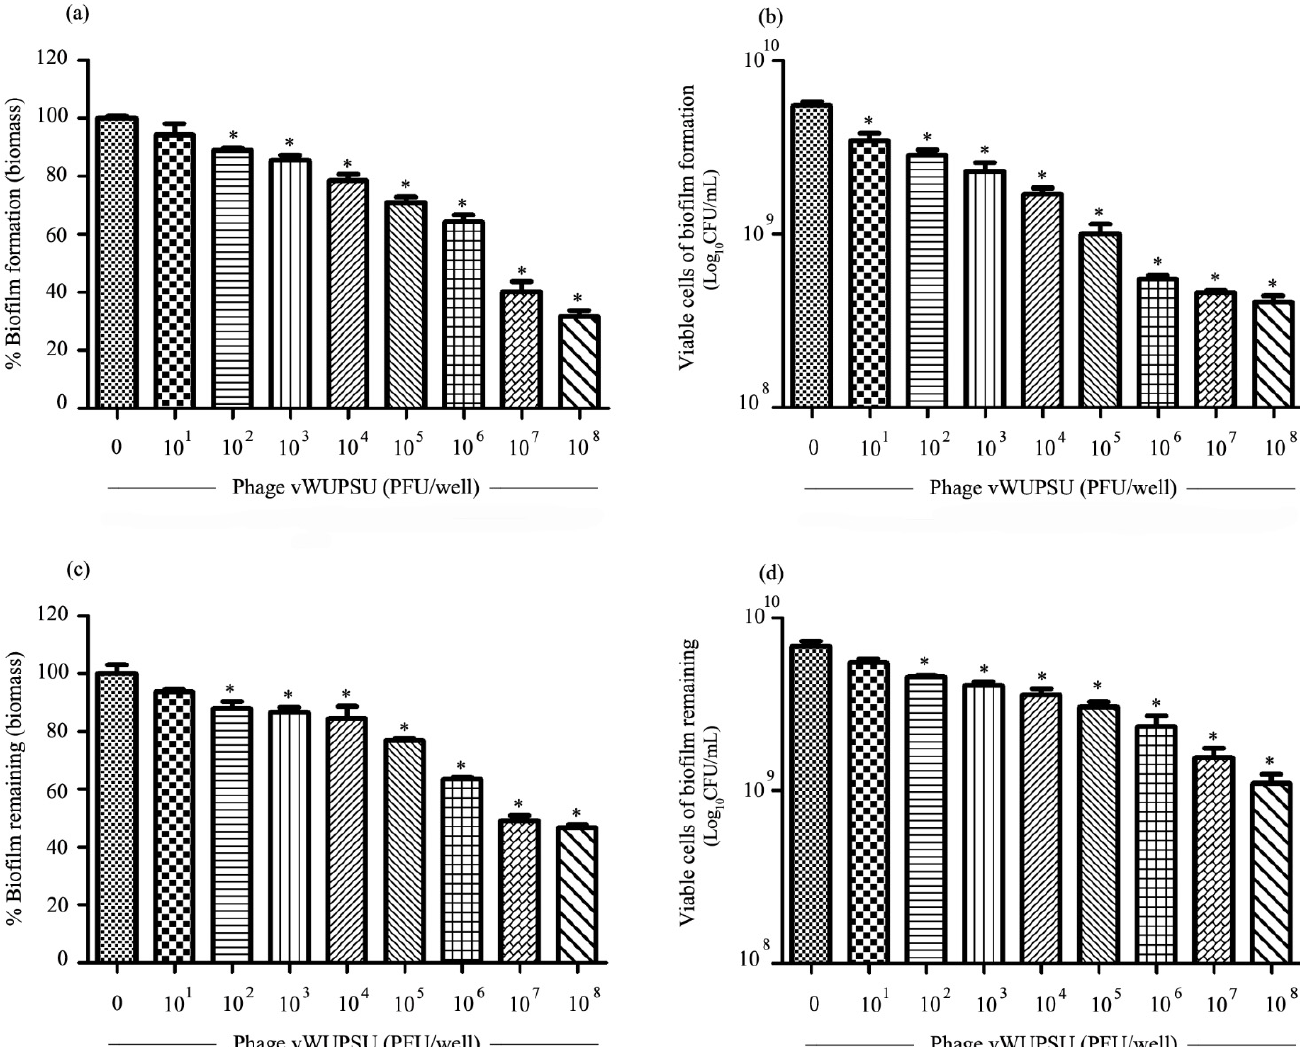
Figure 7. Antibiofilm effect of phage vWUPSU. To determine the activity of phage vWUPSU